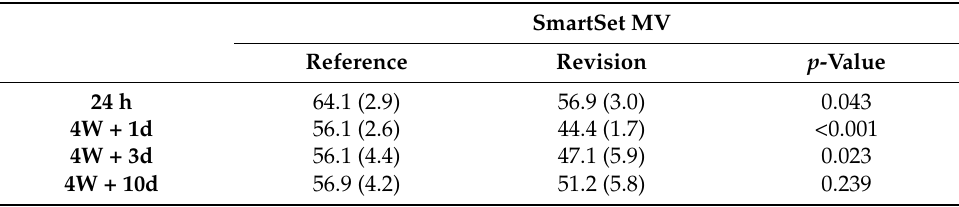
Table 3. Comparison of the bending strength of the SmartSet MV groups. Mean (SD) in MPa.